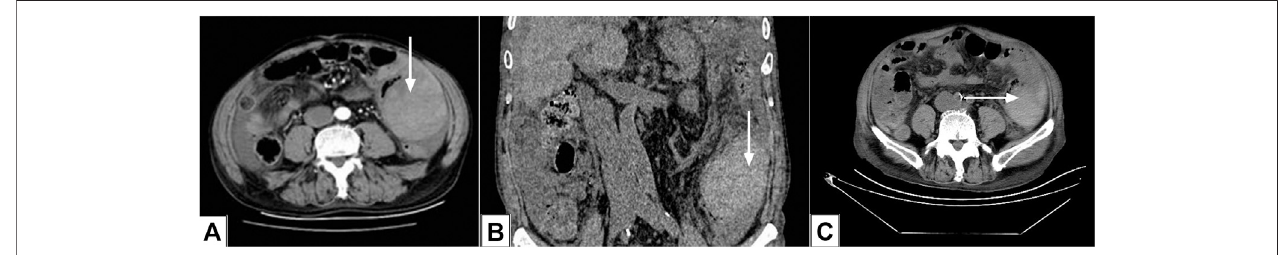
FIGURE1 | Abdominal computed tomography images. (A, B) Contrast-enhanced computed tomography (CT) images showing a hematoma of the colon (arrows) on March 23, 2018; C: CT image revealed that the colon hematoma had been absorbed (arrow) on March 27,